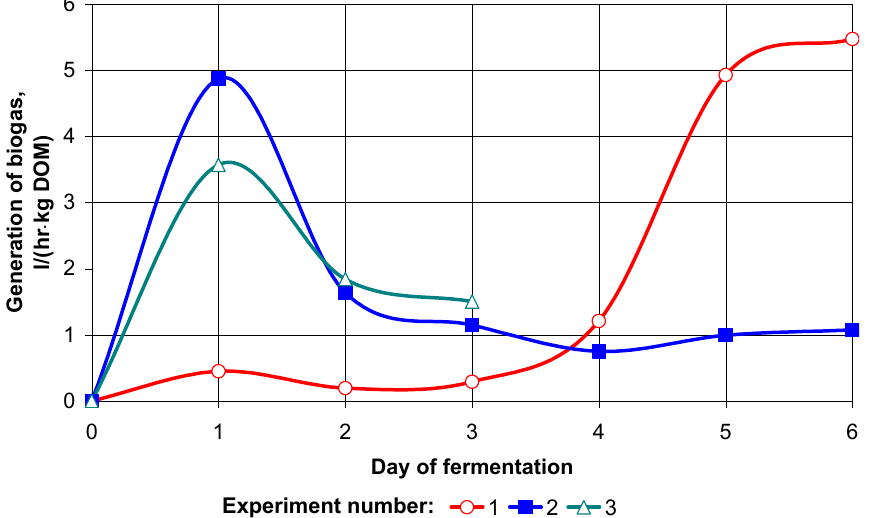
Figure 2. The output of biogas in the mono-fermentation of molasses vinasses at a fermentation temperature of 40 °C: 1 − 20 l of vinasse, pH = 4.7 was added to 10 l of biosludge; 2 − 8.5 l of vinasse, pH = 6.7 was added to 17.5 l of biosludge; 3 − 20 l of substrate, consisting of 3 l of vinasse and 17 l of water, pH = 6.3, was added to 10 l of biosludge.